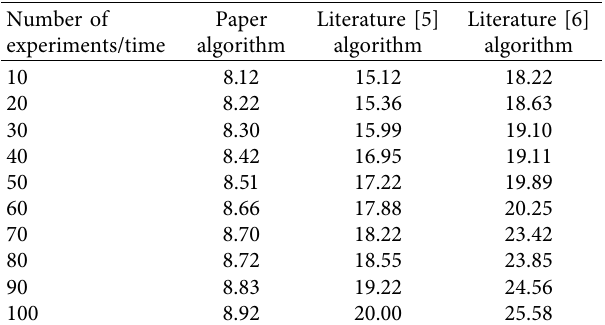
Figure 3: Comparison results of automatic capture accuracy of basketball shooting trajectory with different Table 4: Comparison results of automatic capture time of bas- ketball shooting trajectory of three algorithms/s.